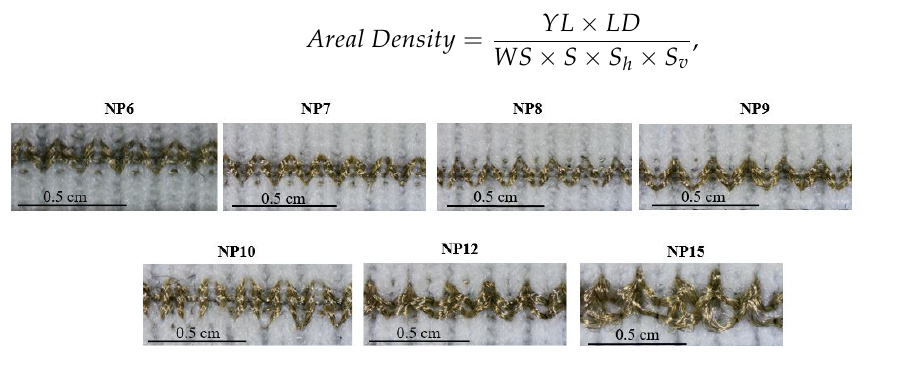
Figure 5. The optical images of knitted strain sensors of the series of NP x Y S 1 C 2 E 1 .